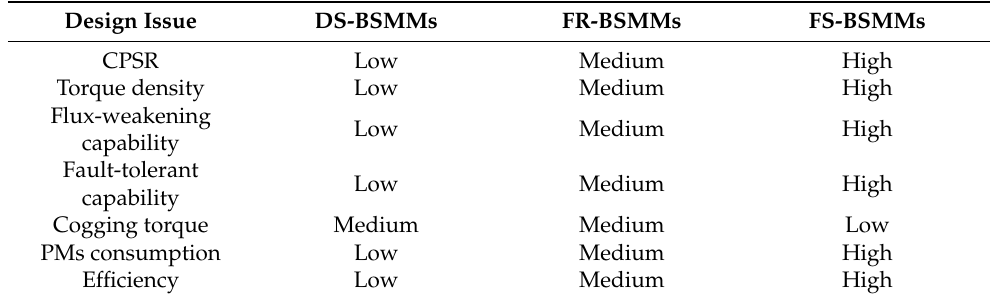
Table 6. Comparison of the three BSMMs for EV applications against Prius-IPM motor benchmark. Design